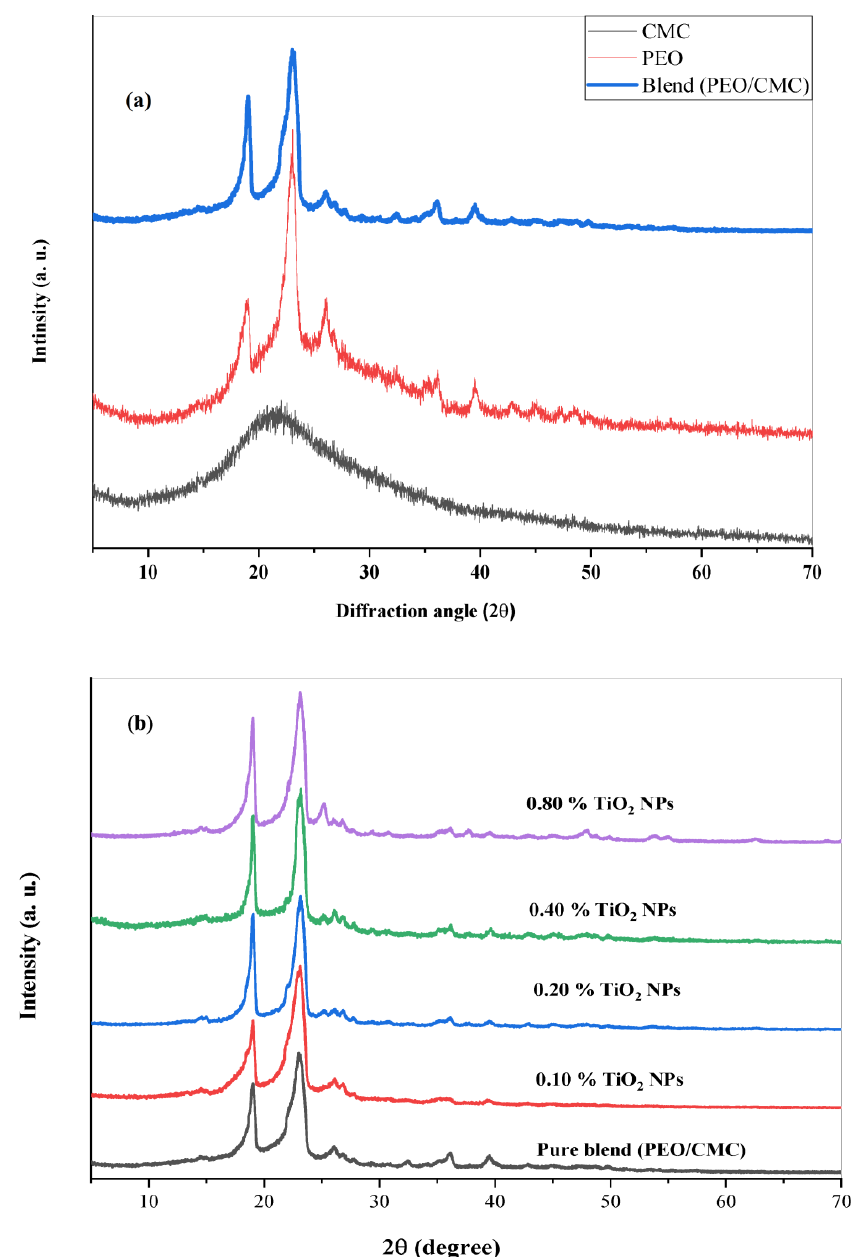
Figure 1. XRD scans of ( a ) pure PEO, pure CMC, and PEO/CMC composite. ( b ) PEO/CMC filled with different amounts of TiO 2 NPs